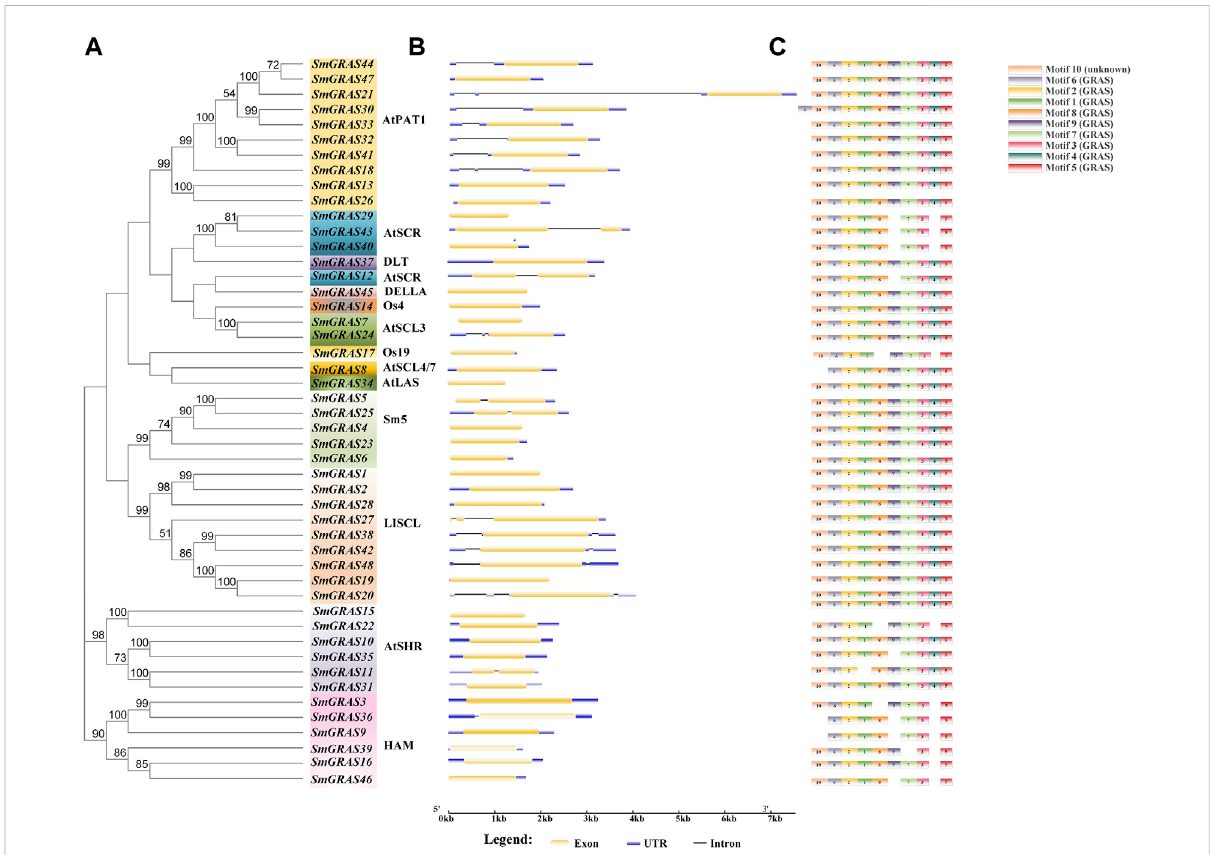
FIGURE 1 Phylogenetic tree, gene structure, and conserved motif of 48 GRAS transcription factors in eggplant. (A) Maximum likelihood (ML) tree generated by MEGA-X under the LG + G model with bootstrapping analysis (1,000 replicates). (B) Exon – intron structures of SmGRASs generated by the online software GSDS. (C) Conserved motifs of SmGRASs were further annotated with the CDD